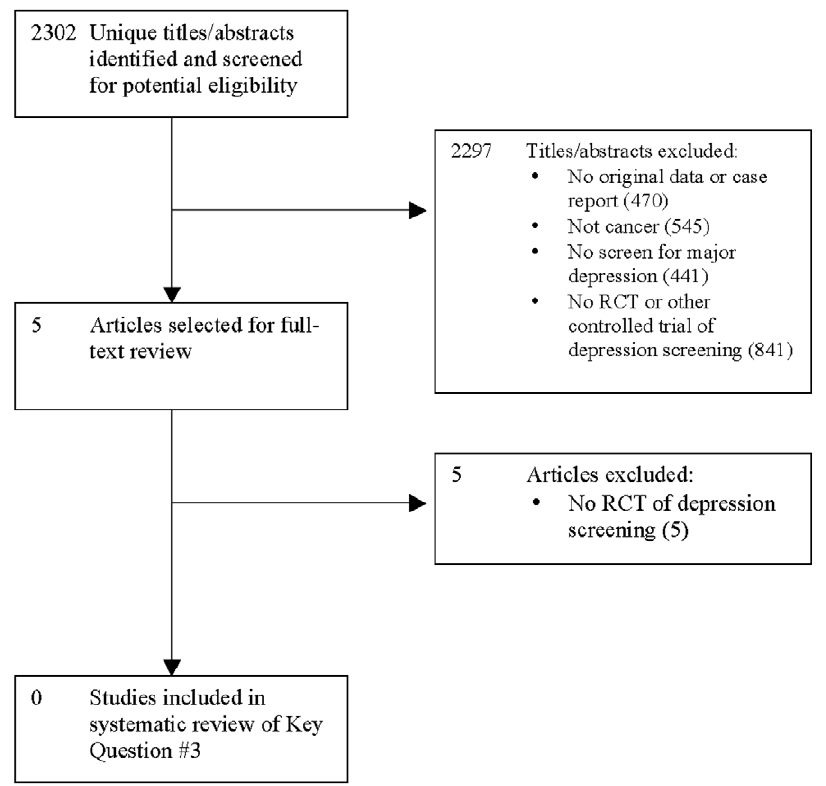
Figure 4. PRISMA Flow Diagram of Study Selection Process for Key Question # 3.